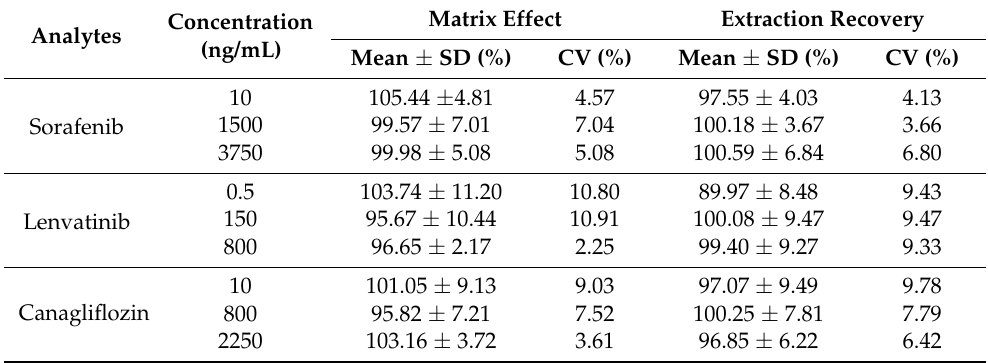
Table 2. Matrix effect and extraction recovery of sorafenib, lenvatinib, and canagliflozin in rat plasma (n = 6).